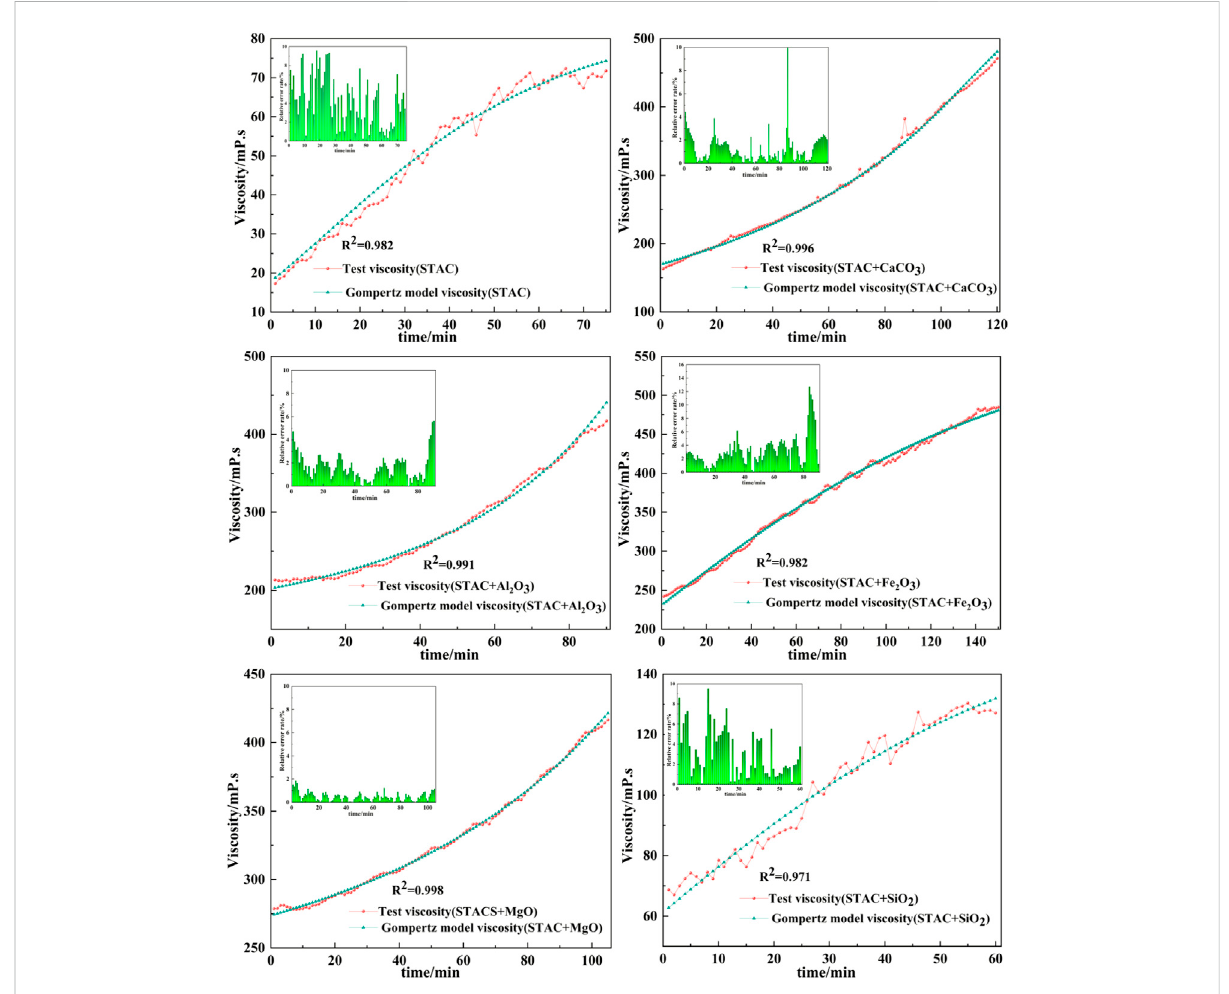
FIGURE 14 Fit of Gompertz model curves and experimental data for viscosity versus time for the STAC emulsi fi ed asphalt mortars.